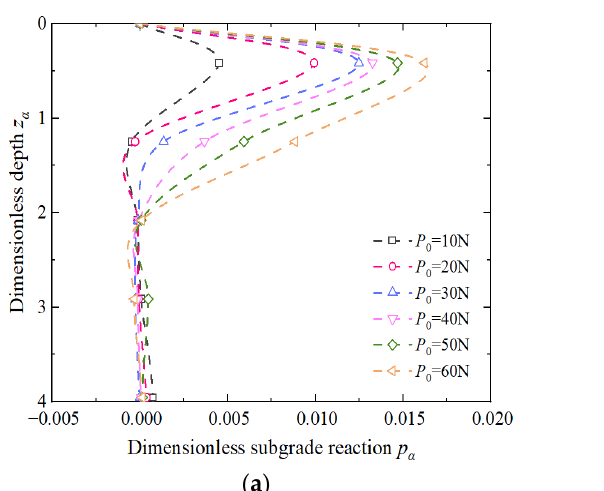
Figure 9. Predicted dimensionless deflections in lateral static loading tests. ( a ) in level ground; ( b ) in sloping ground.